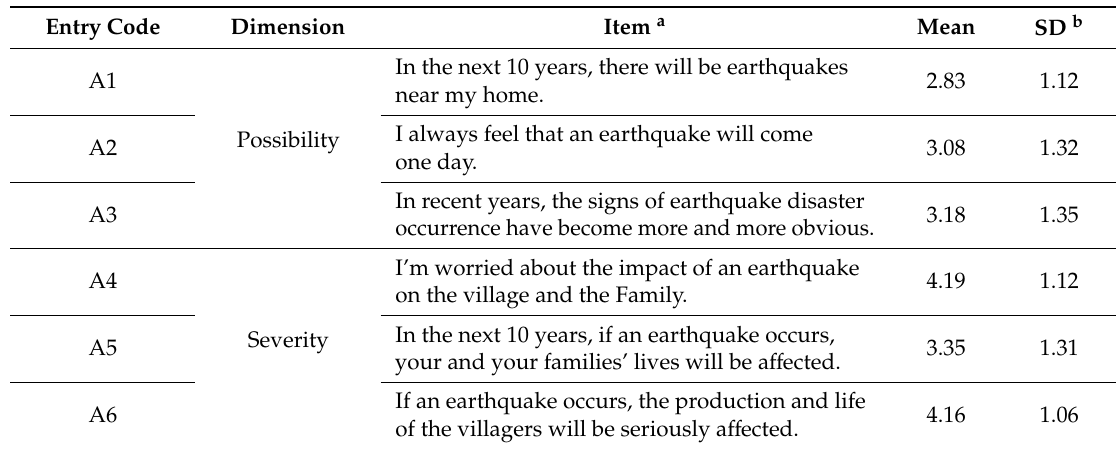
Table 1. Earthquake disaster risk perception measurement.